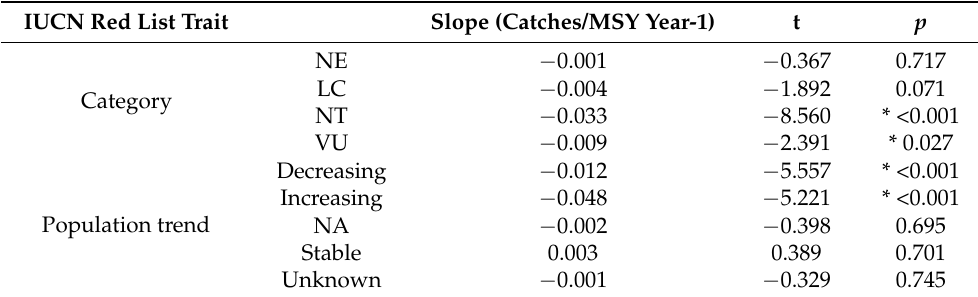
Table 3. Linear models for the trends in catches/MSY ratio between 1996 and 2020 for IUCN Red List categories and population trends. LC: Least Concern, NT: Near Threatened, VU: Vulnerable, NE: Not Evaluated.